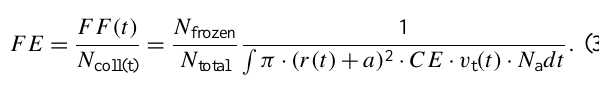
Fig. 1. Diagram of the different collision pathways between aerosol particles and cloud droplets relevant to contact freezing (Ladino,